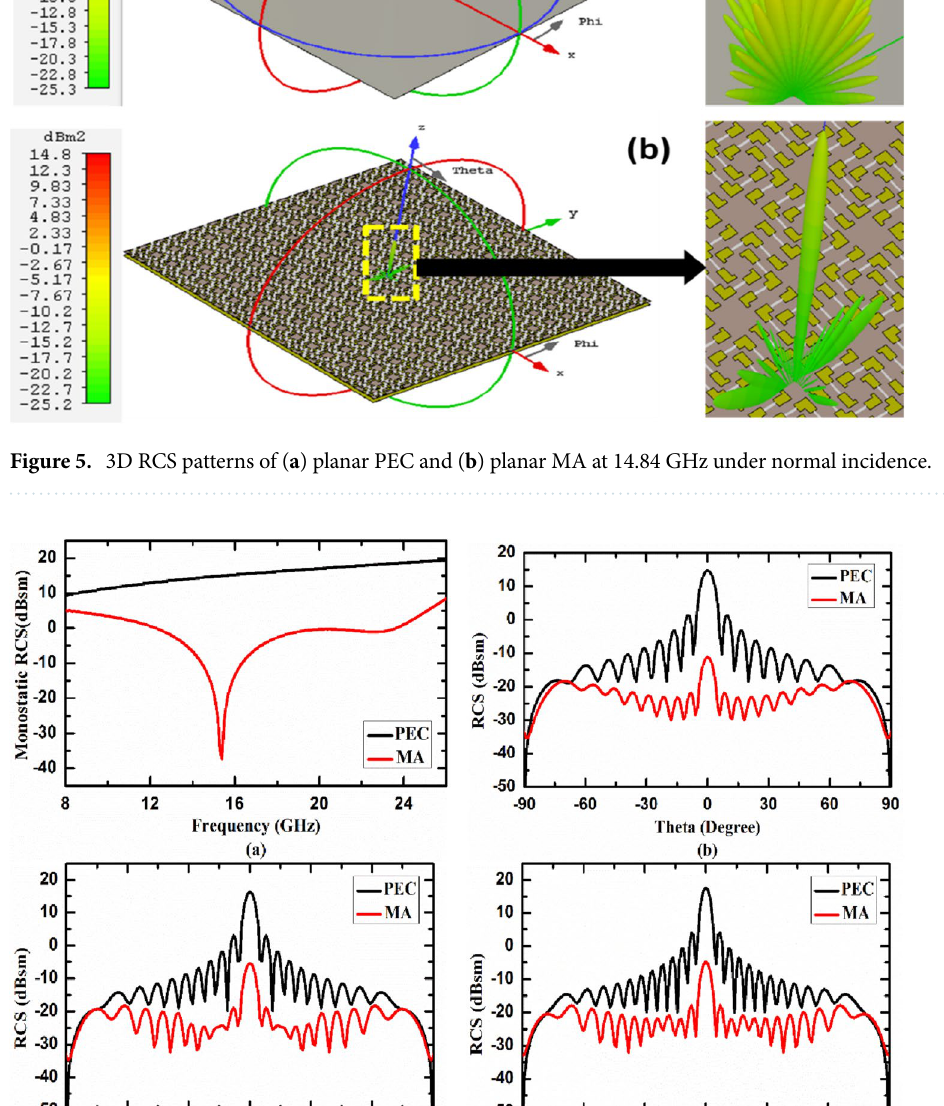
monostatic RCS of the planar PEC plate (shown by black curve) and planar MA (shown by red curve) as a function of frequency under normal incidence are plotted. It is evident from the figure that proposed absorber achieved nearly 20 dB RCS reduction in the given frequency band (13.42–22.66 GHz) as compared to PEC plate under normal incidence. To study the performance of planar MA under different observation (receiving antenna) angles, we have calculated bistatic RCS of planar MA and planar PEC under normal incidence. In this case, transmitting antenna is kept at 0° with respect to the normal to the surface of MA and receiving antenna is